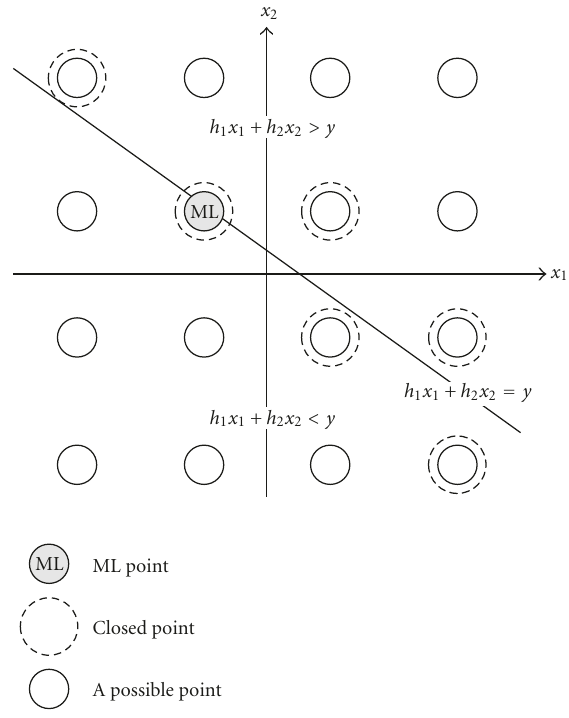
Figure 1: A diagram showing the decoding line when Q = {− 3, − 1,1,3 } and K =